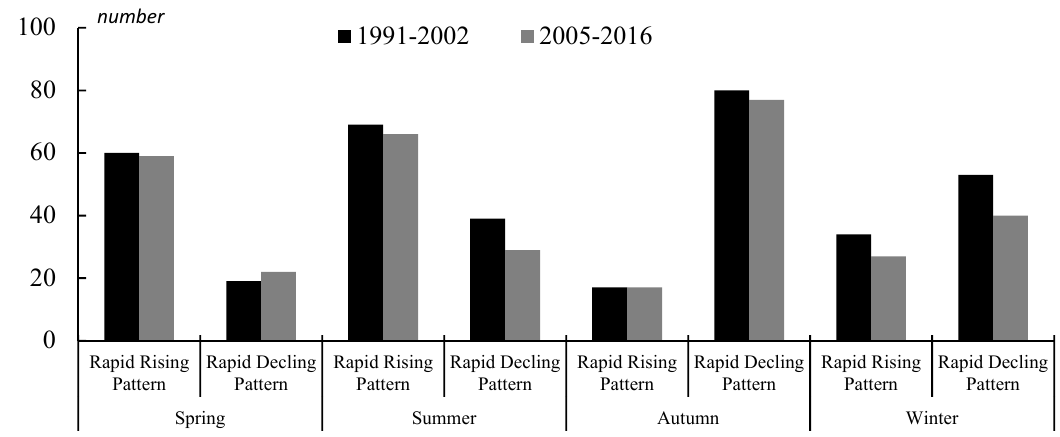
Figure 8. The statistical results of fluctuation patterns of spring, summer, autumn, and winter during the two periods. (Because of the small number of slow variation patterns, they are not listed.).